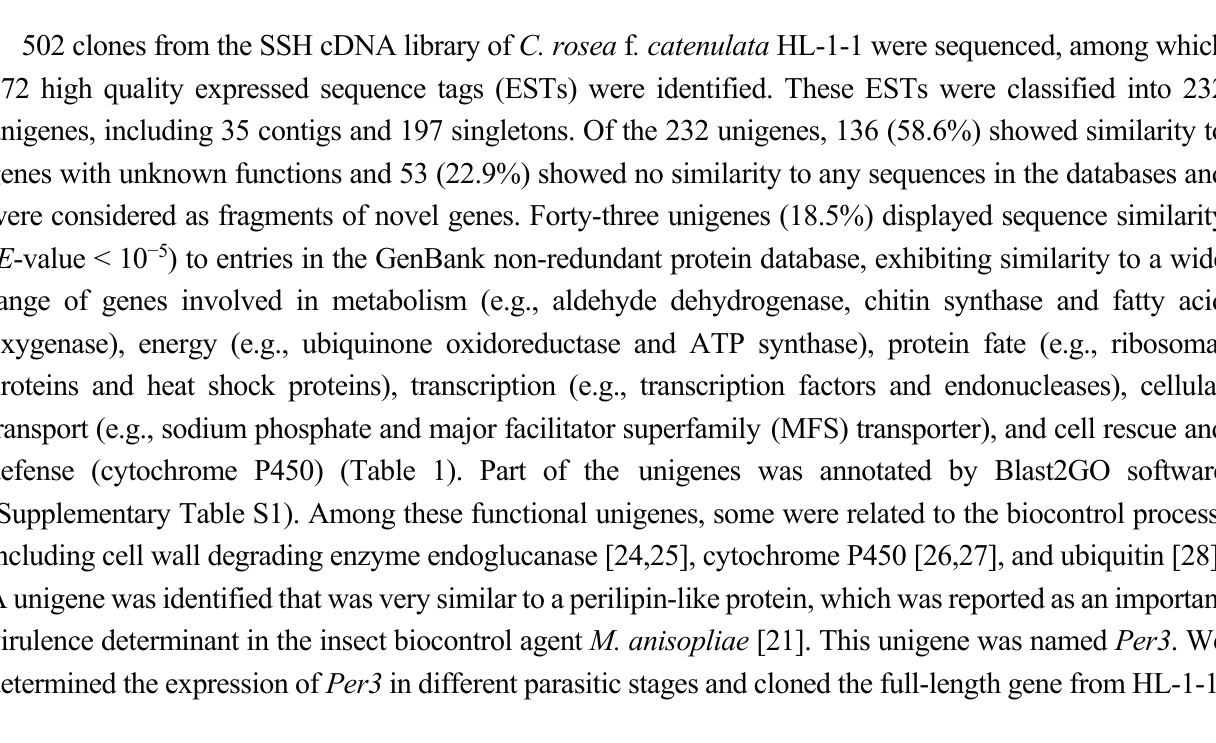
Table 1. Functional analysis of differentially expressed genes in C. rosea f. catenulata HL-1-1 parasitizing the sclerotia of S. sclerotiorum by